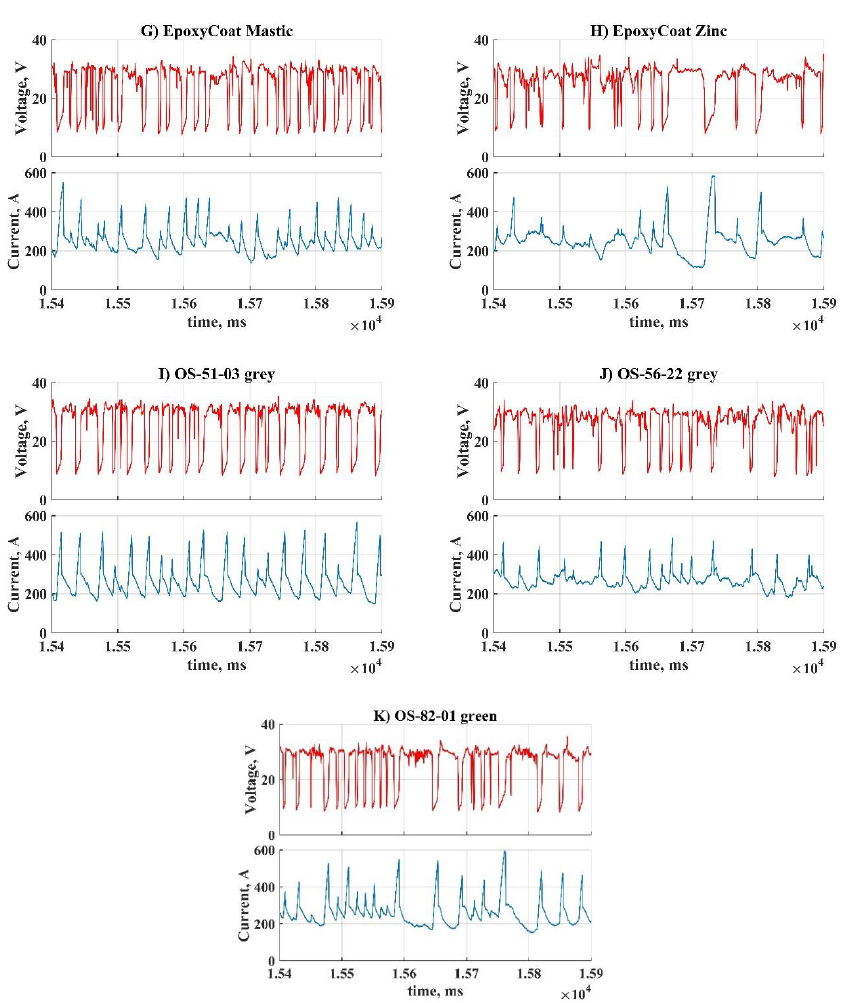
Figure 3. Oscillograms of the process during welding with each coating: ( A ) No coating;( B ) АК -070; ( C ) VL-023; ( D ) GF-021 Express; ( E ) EpoxyCoat-0263S; ( F ) EpoxyCoat-019; ( G ) EpoxyCoat Mastic; ( H